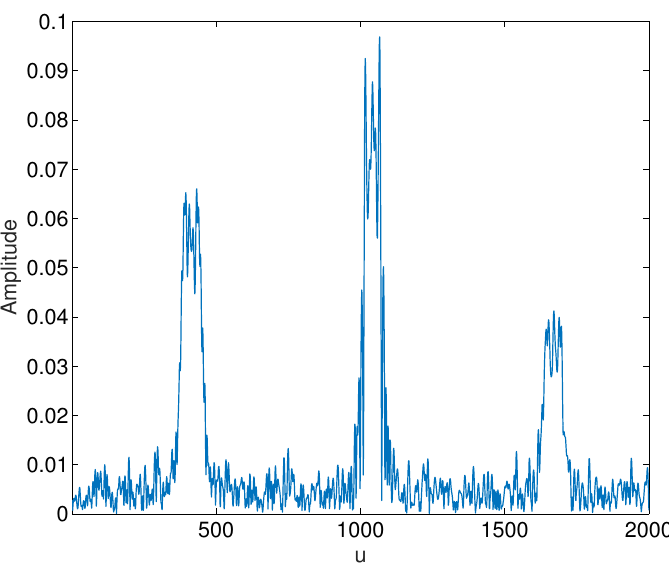
Figure 6. Linear canonical transform of the signal before multipath interference suppression.